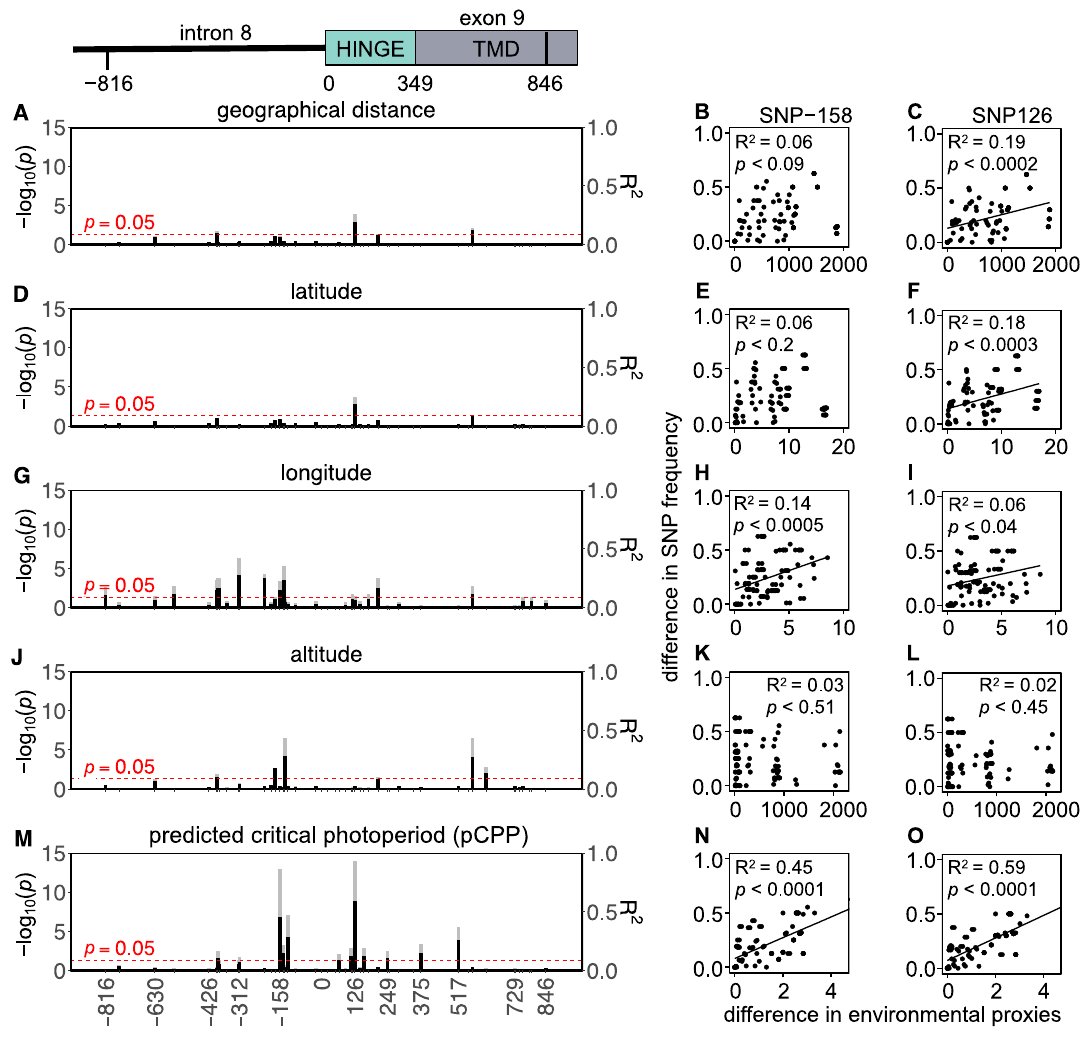
Figure 4. Tshr mutations in Western European common vole populations. Manhattan-type plots ( − log 10 ( p )) for the sequenced Tshr region for ( A ) geographical distance, ( D ) latitude, ( G ) longitude, ( J ) altitude, and ( M ) predicted critical photoperiod (pCPP). Gray bars indicate Benjamini–Hochberg adjusted p -values, and black bars indicate R 2 -values. SNPs that meet the threshold for significant correlations ( p < 0.05) cross the red dashed line. Pairwise differences in SNP frequency for two representative mutations (SNP-158 and SNP126) related to ( B , C ) pairwise geographical distance, ( E , F ) pairwise latitudinal difference, ( H , I ) pairwise longitudinal difference, ( K , L ) pairwise altitudinal difference, and ( N , O ) pairwise difference in pCPP. Significant correlations are indicated by linear regression lines. All statistic results of linear models for SNP frequency related to environmental proxies are found in Table